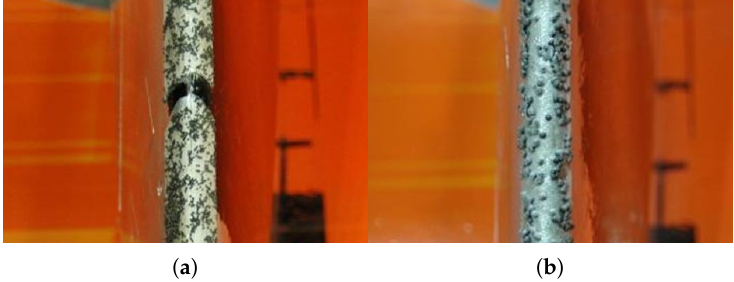
Figure 4. Additional very rough carborundum grits. ( a ) h d / l µ = 0.125% ( h d = 1 mm); ( b ) h d / l µ = 0.250% ( h d = 2